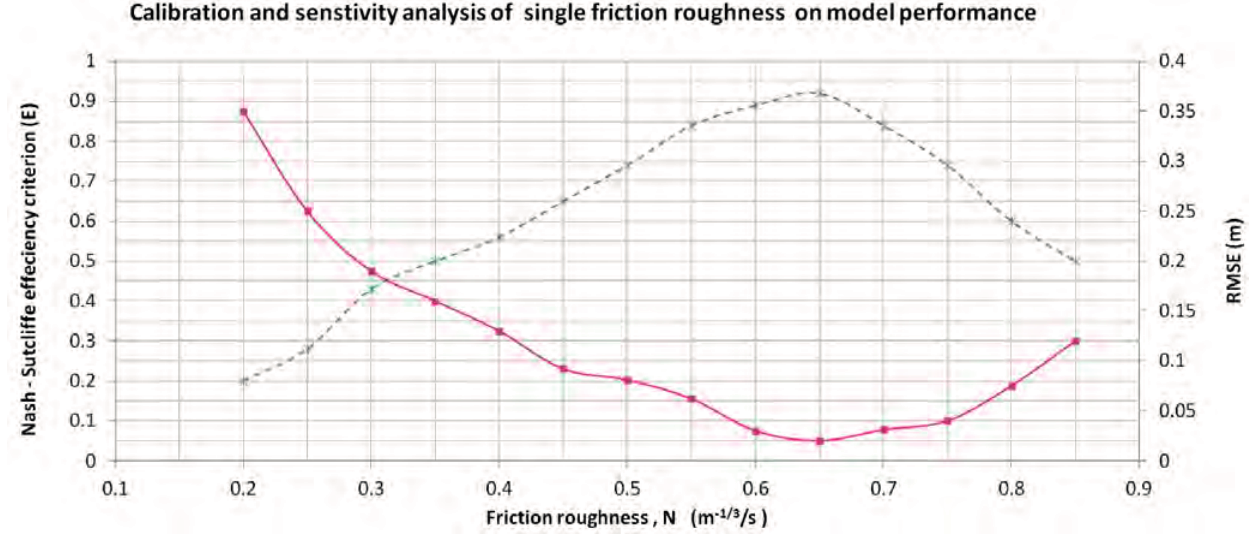
Figure 13. Calibration and sensitivity analysis of single friction roughness on model performance (SWL1). Friction roughness ( n ), Root Mean Square Error (RMSE) for observed and simulated water level